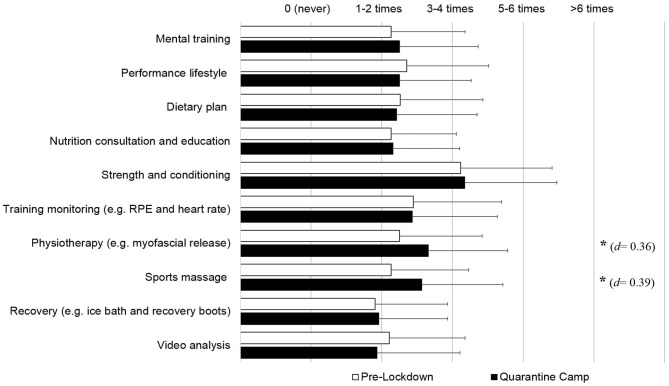
Survey section 3; Utilization of performance support pre-lockdown and during the “quarantine” camp. Athletes indicated how frequently, on a monthly basis, they utilized performance support on a 5-point scale of “0 or never,” “1–2 times,” “3–4 times,” “5–6 times,” and “more than 6 times.” * Significant difference (p < 0.05) between pre-lockdown and “quarantine” camp.